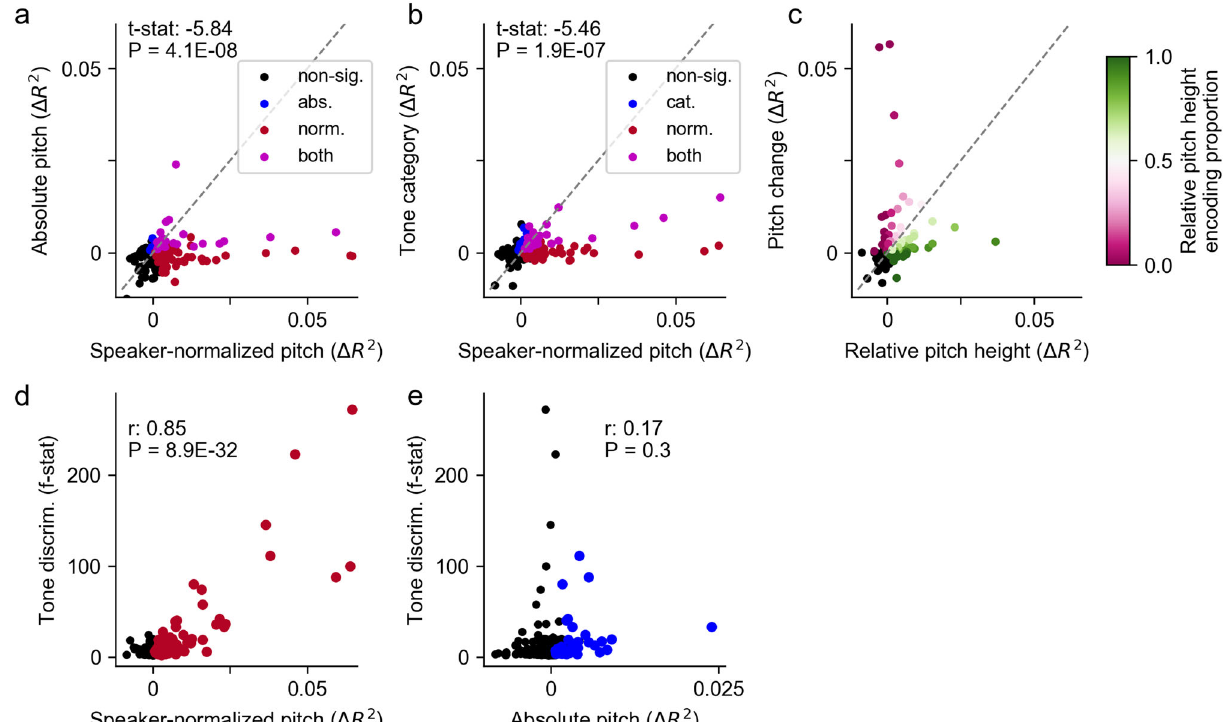
Fig. 3 Encoding of speaker-normalized relative pitch height and pitch change, but not tone category or absolute pitch, underlies lexical tone discriminability at individual electrodes. a Scatterplot of the unique variance explained by absolute pitch and by speaker-normalized pitch features, across speech-responsive electrodes from all Mandarin-speaking participants. Each dot represents a single-electrode. Colored dots indicate signi fi cant encoding of absolute pitch only (blue), speaker-normalized pitch only (red) or both (magenta). The t statistic is computed using paired t test between absolute pitch ( R 2 ) and speaker-normalized pitch ( R 2 ). b Scatterplot comparing the relationship between the unique variance explained by speaker-normalized pitch features and discrete tone category features in the full encoding model in single electrodes. Colored dots indicate signi fi cant encoding of tone category only (blue), speaker-normalized pitch only (red) or both (magenta). The t statistic is computed using paired t test between-tone category ( R 2 ) and speaker- normalized pitch ( R 2 ). c Scatterplot of the unique variance explained by relative pitch and by pitch change in single electrodes. Colored dots indicate signi fi cant encoding of either set of features, with the color indicating the proportion of the variance explained by the corresponding feature set. d Unique variance explained by speaker-normalized pitch features and tone discriminability. Colored dots indicate electrodes that had signi fi cant encoding of speaker-normalized pitch features ( p < 0.01, permutation test). The r value is computed using Pearson ’ s correlation between-tone discriminability ( F value) and speaker-normalized pitch ( R 2 ). e Unique variance explained by absolute pitch and tone discriminability. Colored dots indicate electrodes that had signi fi cant encoding of absolute pitch ( p < 0.01, permutation test). The r value is computed using Pearson ’ s correlation between-tone discriminability ( F value) and absolute pitch ( R 2 ). P values in ( a , b , d , e ) are computed using two-sided t